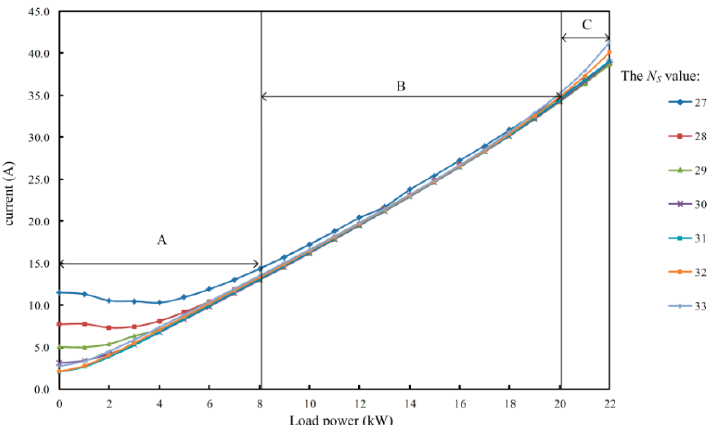
Figure 7. The current varies with the stator winding turns.